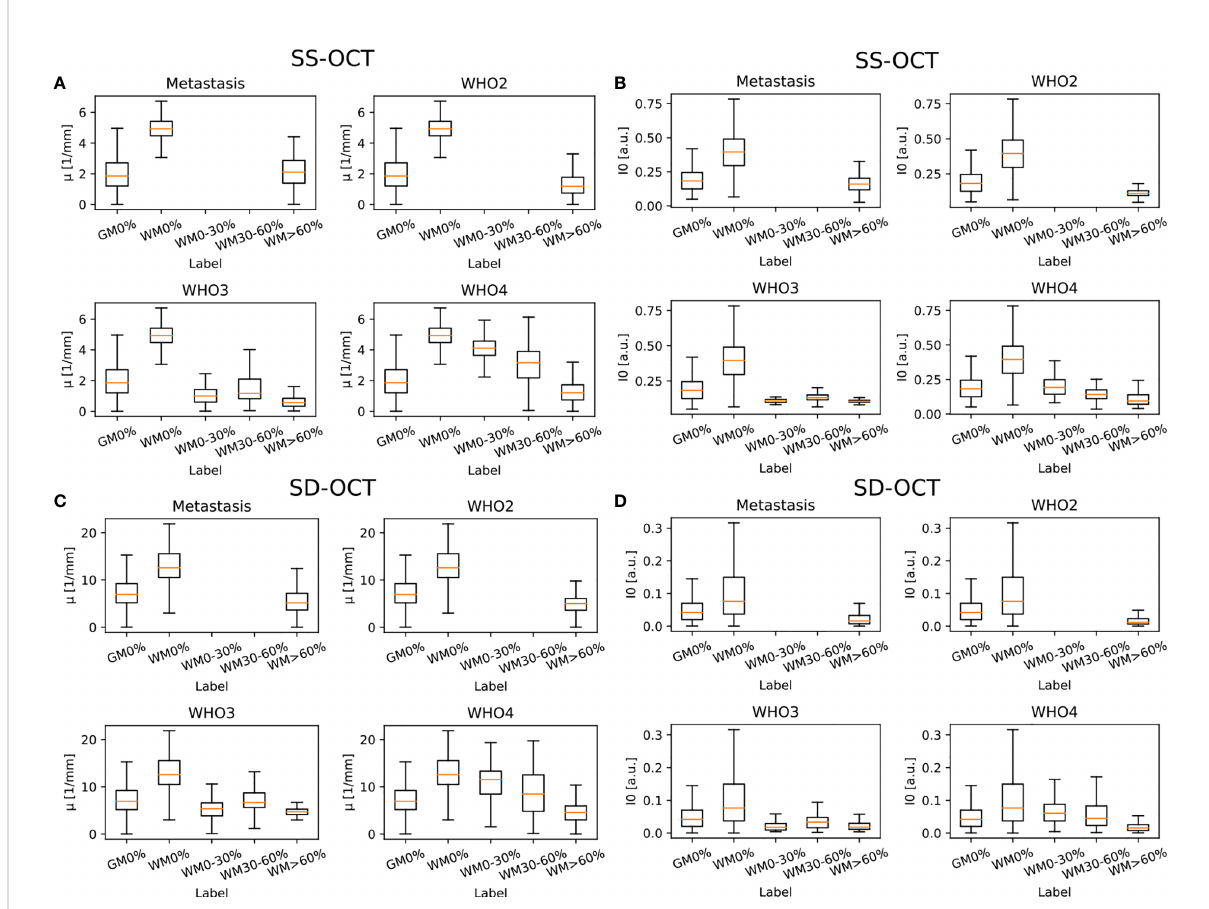
FIGURE 6 Determined optical properties m (SS-OCT: (A) SD-OCT: (C) and I 0 (SS-OCT: (B) SD-OCT: (D) for the four different pathologies (median value = orange line). Note that I 0 was normalized to the maximum determined I 0 . The optical properties were determined for the following label: GM0%, gray matter 0% tumor in fi ltration; WM0%, white matter 0% tumor in fi ltration; WM0 – 30%, white matter with 0 – 30% tumor in fi ltration; WM30 – 60%, white matter with 30 – 60% tumor in fi ltration; and WM>60%, white matter with >60% tumor in fi